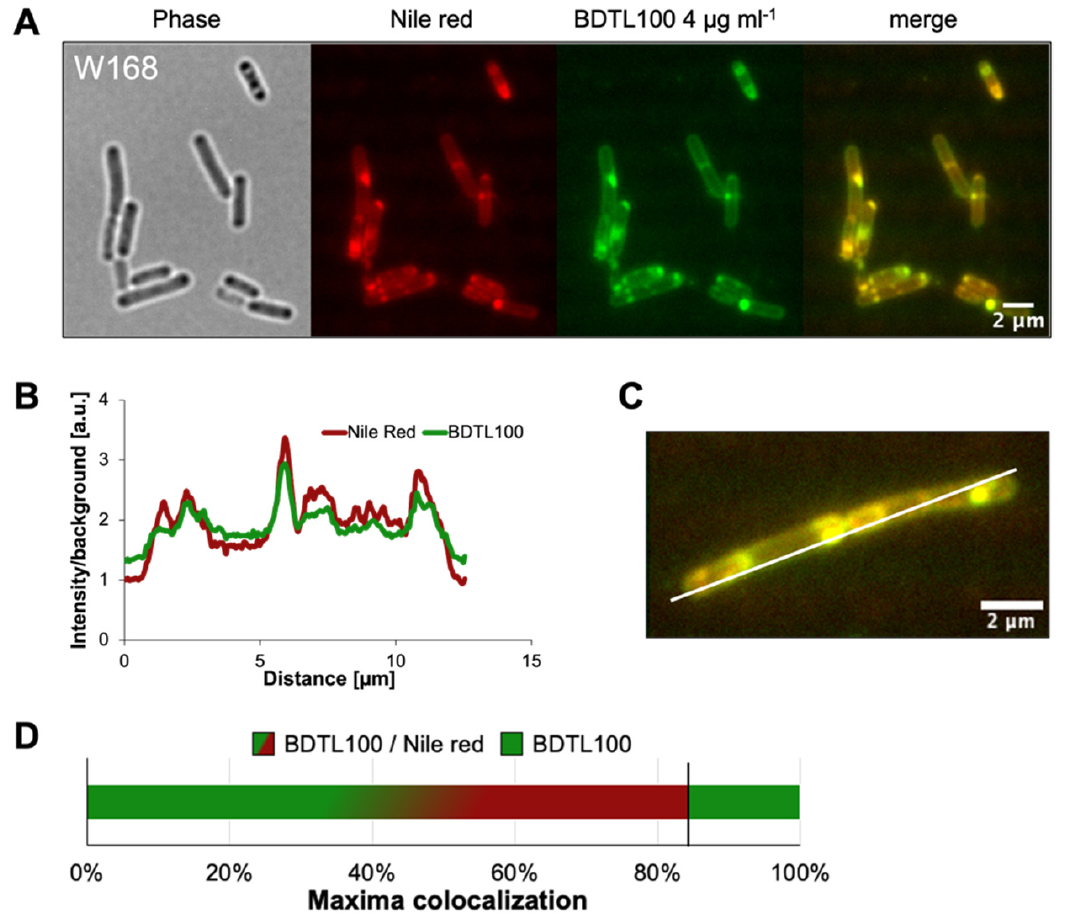
Figure 3. BDTL100 disturbs membrane homeostasis by inducing lipid domain formation in vivo . ( A ) B. subtilis W168 cultures were treated for 20 min (for 5 min treatment see (Supplementary Figure